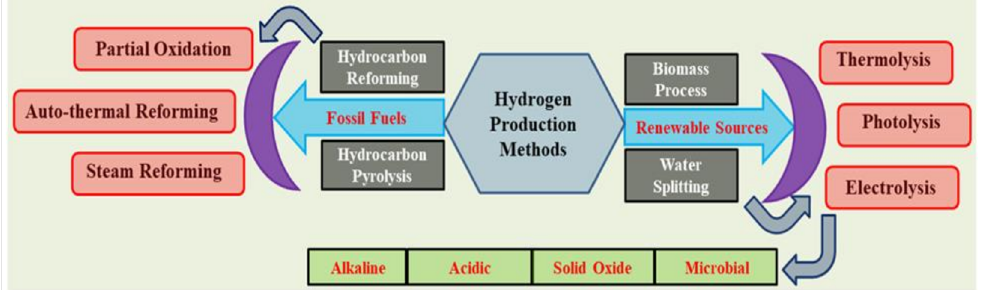
Figure 1. Methods for the production of